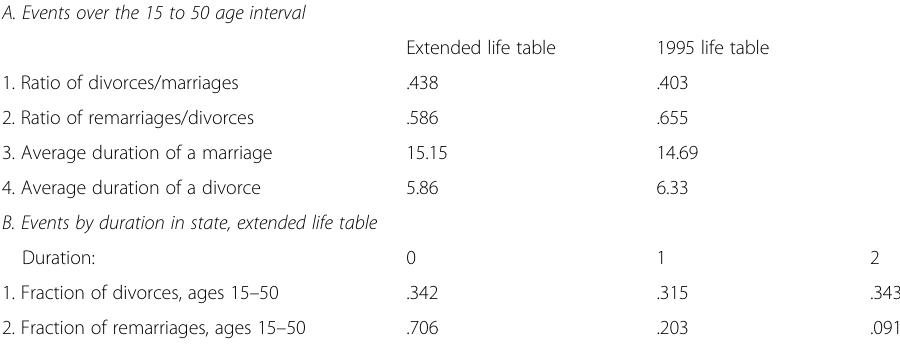
Table 4 State-duration life table summary measures of marriage and divorce, United States Females, 1995 A. Events over the 15 to 50 age